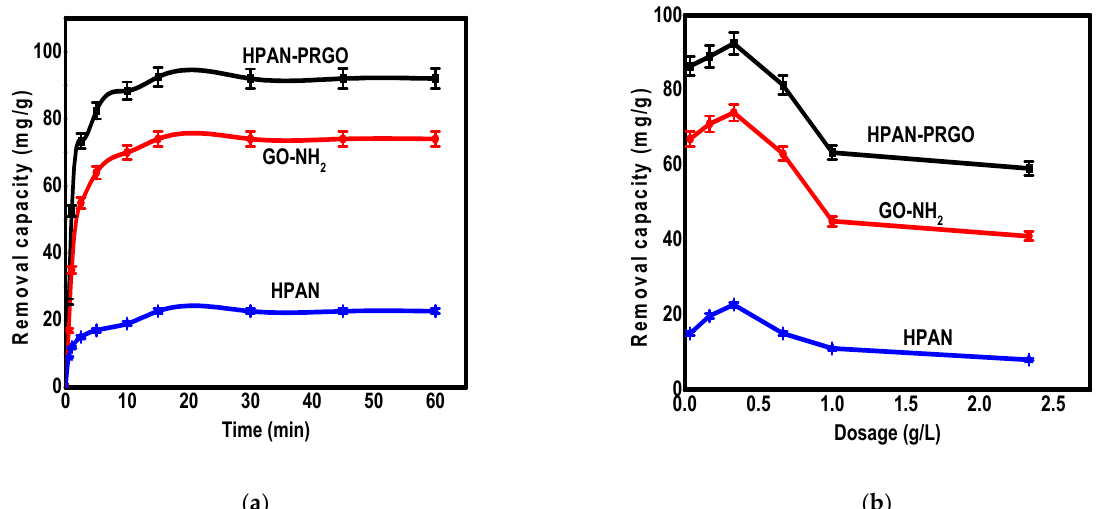
Figure 6. The effect of ( a ) contact time and ( b ) the dose on Sm 3+ removal over HPAN-PRGO, GO-NH 2 , and HPAN.